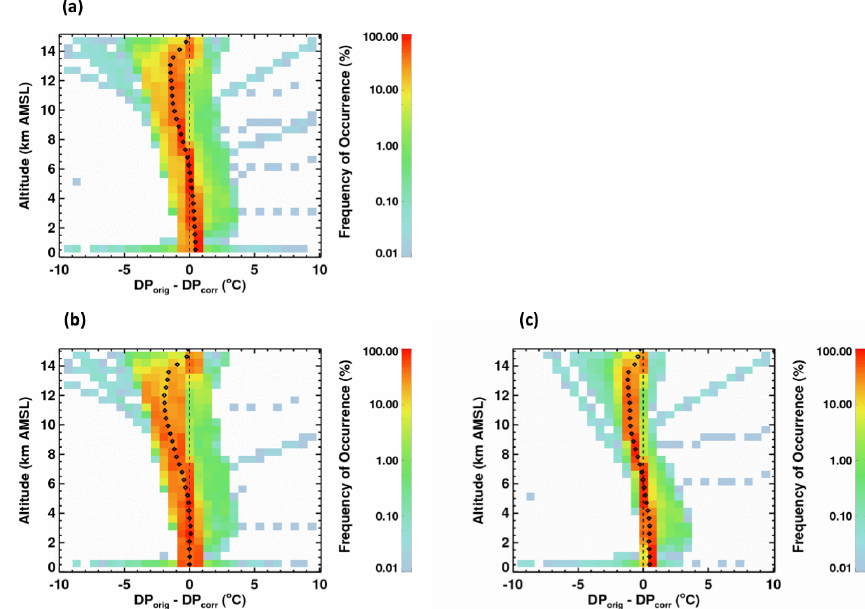
Figure 4. Two-dimensional histogram of humidity differences. Dew point (DP) difference between the original sounding and the humidity- corrected sounding for all soundings (a) , daytime soundings (b) and nighttime soundings (c) . The dotted black curve represents the median value at each